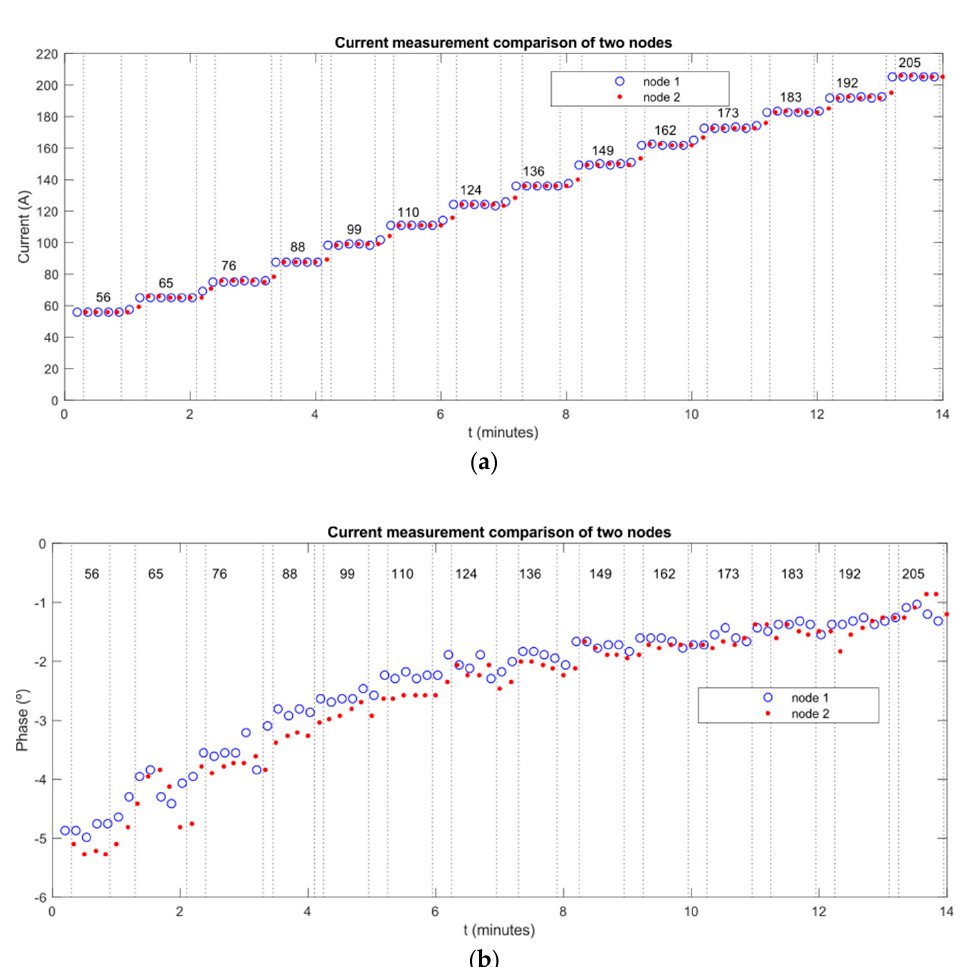
Figure 18. (a) Coupled transformer; and (b) high-current transformer.